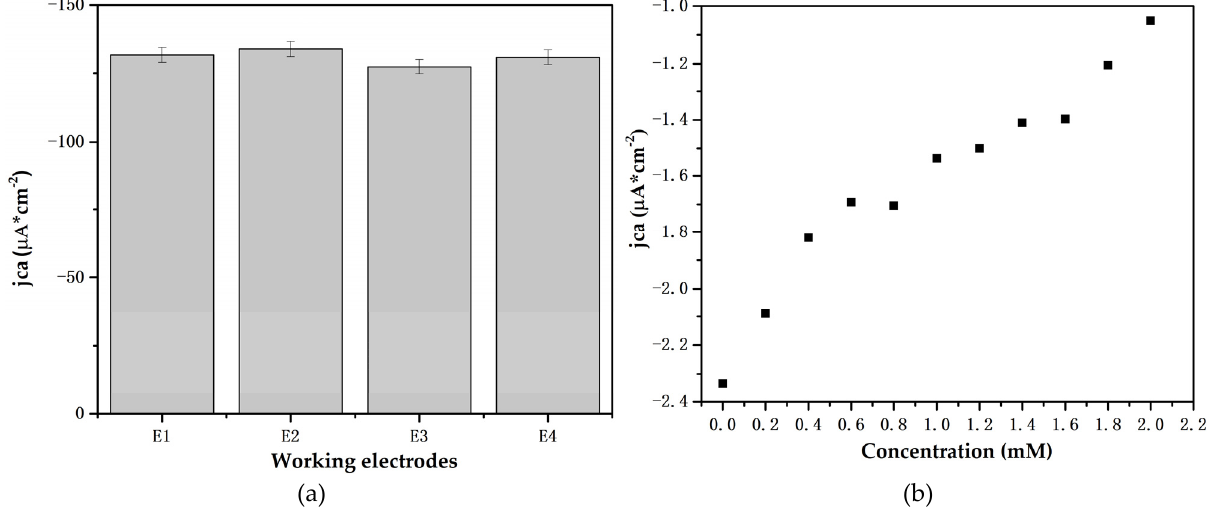
Figure 10. ( a ) Cathodic current density of the five Ti/TiO 2 electrodes in pH 7 PBS and glucose at 1Mm. ( b ) Cathodic current density of a Ti/TiO 2 electrode in artificial saliva solution at 330 s.